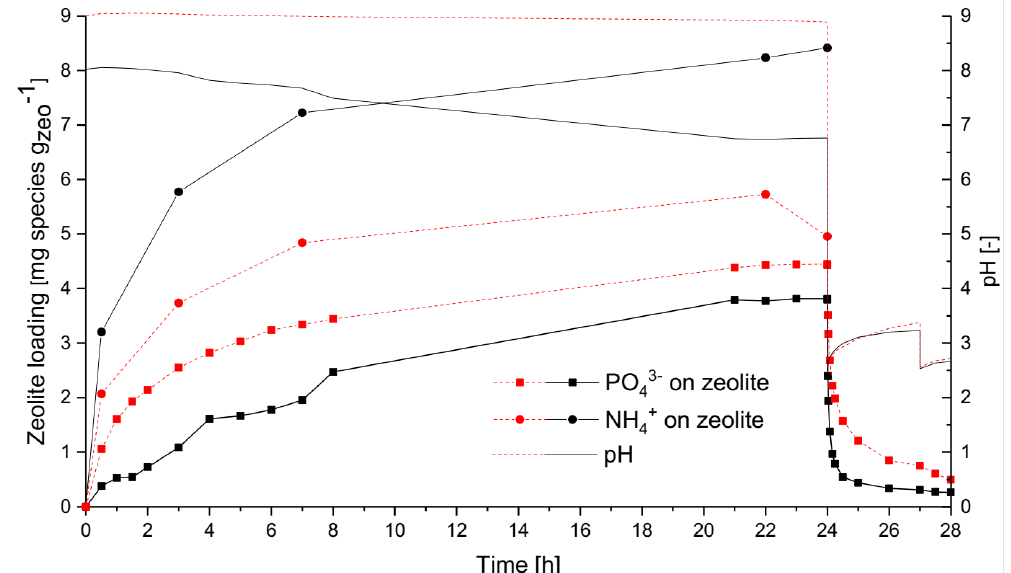
Figure 4. Effect of initial pH value on P-removal. Initial values of experiments: black solid lines: 257 mg NH 4+ L − 1 . 126 mg PO 43 − L − 1 pH = 8.02, removal rates: P = 61%, N = 65%; red dashed lines: 250 mg NH 4+ L − 1 . 125 mg PO 43 − L − 1 pH = 9.00, removal rates: P = 71% N = 43%.